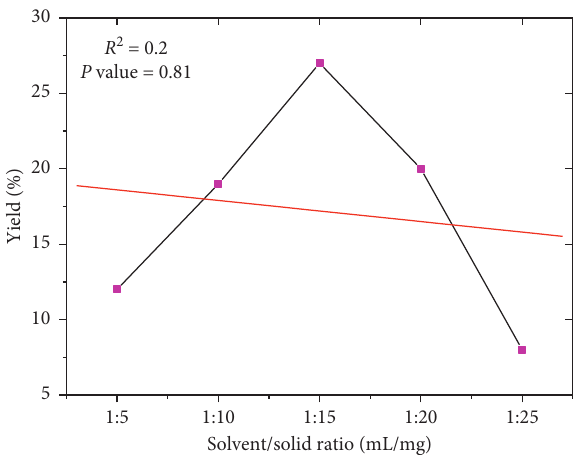
Figure 3: Effect of solvent-to-material ratio on yield extraction of